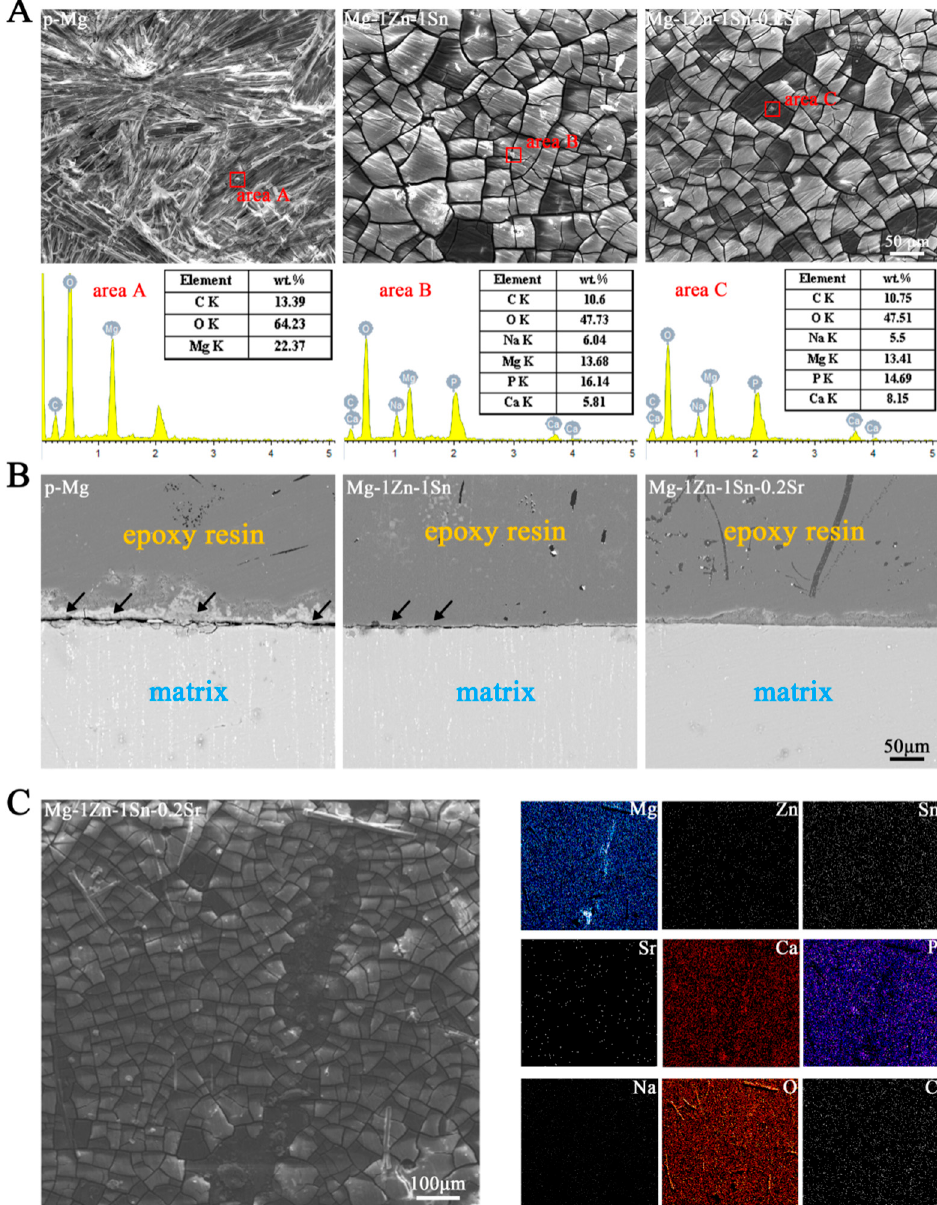
Figure 5. ( A ) Surface topographies and EDS results of p-Mg, Mg-1Zn-1Sn and Mg-1Zn-1Sn-0.2Sr alloys after 7 days of immersion in SBF; scale bar = 50 μ m. ( B ) The morphologies of the cross-section of p-Mg, Mg-1Zn-1Sn and Mg-1Zn-1Sn-0.2Sr alloys after 7 days of immersion in SBF; scale bar = 50 μ m. The black arrow indicates corrosion products. ( C ) SEM-EDS composite image of the surface of Mg-1Zn-1Sn-0.2Sr sample immersed in SBF at 37 °C for 7 days, scale bar = 100 μ m.